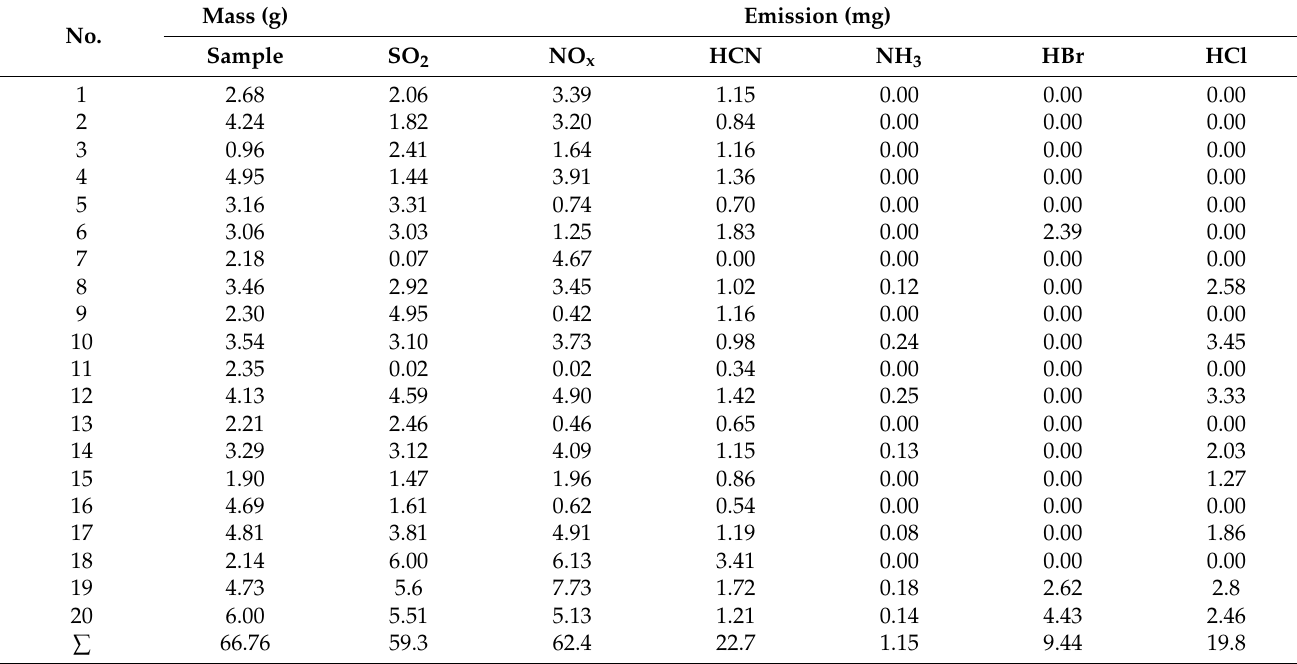
Table 6. Emission of SO 2 , NO x , HCN, NH 3 , HBr and HCl in the exhaust gases obtained during thermal treatment of waste mobile phones in a fluidised